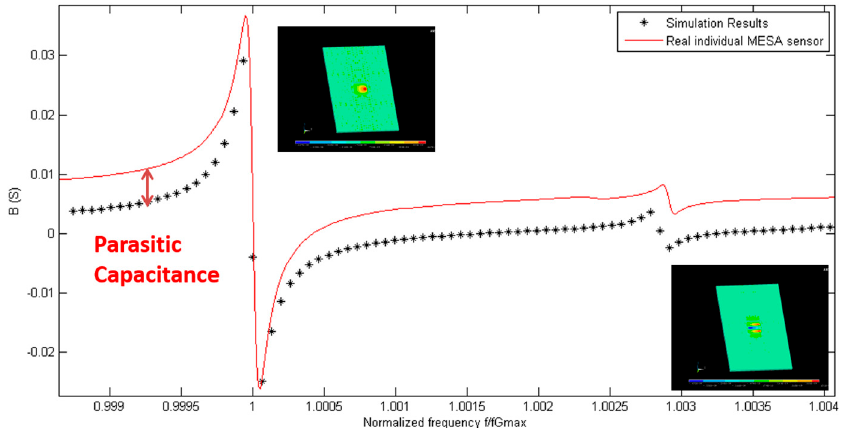
Figure 7. Comparison of the imaginary part of the electrical admittance (B) measured in air of the manufactured AWS HFF-QCM sensor, and the response provided by the numerical model.